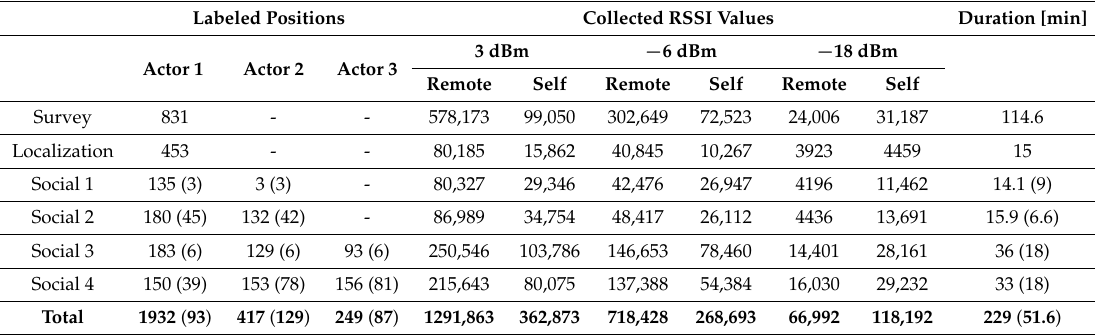
Table 1. Dataset overview. The number of labeled positions during a meeting and the total duration of meetings are shown in brackets.